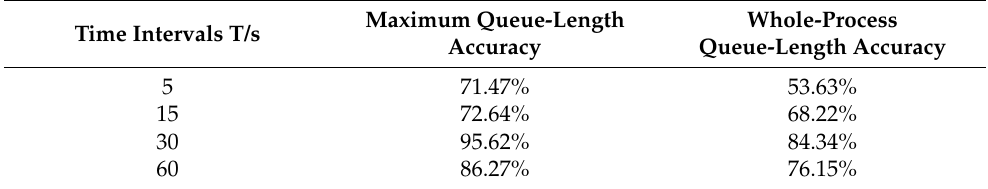
Table 6. Comparison of queuing length accuracy at different time intervals